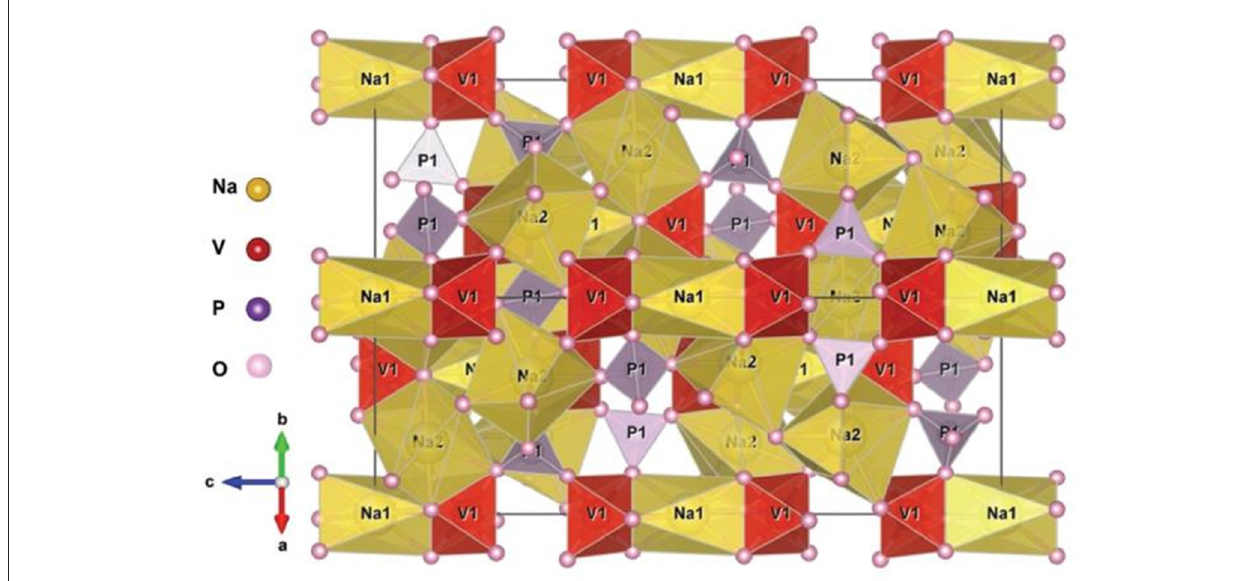
FIGURE 2 | Structure scheme of Na 3 V 2 (PO 4 ) 3 .